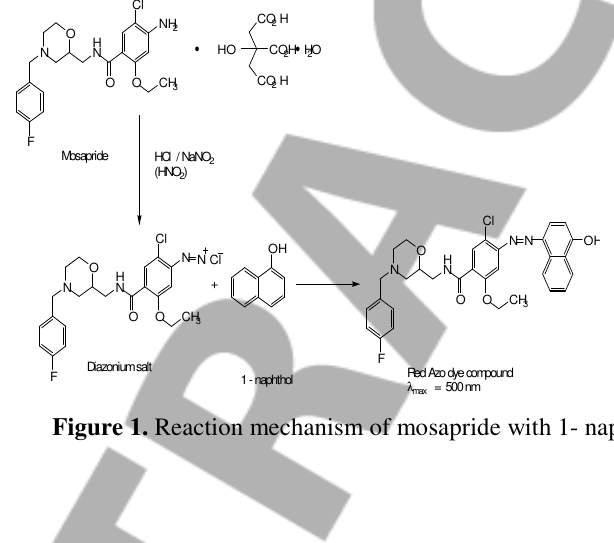
Figure 1. Reaction mechanism of mosapride with 1- naphthol